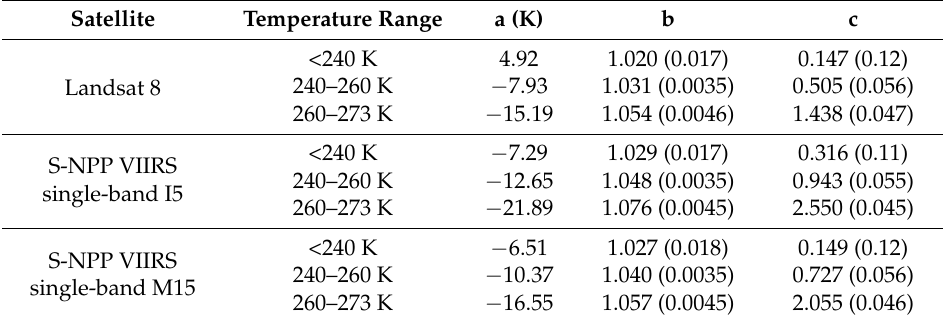
Table 5. S-NPP VIIRS and Landsat 8 single-band ice surface temperature retrieval coefficients and the standard errors (in parenthesis) of the coefficients in the Arctic as in Equation (3).